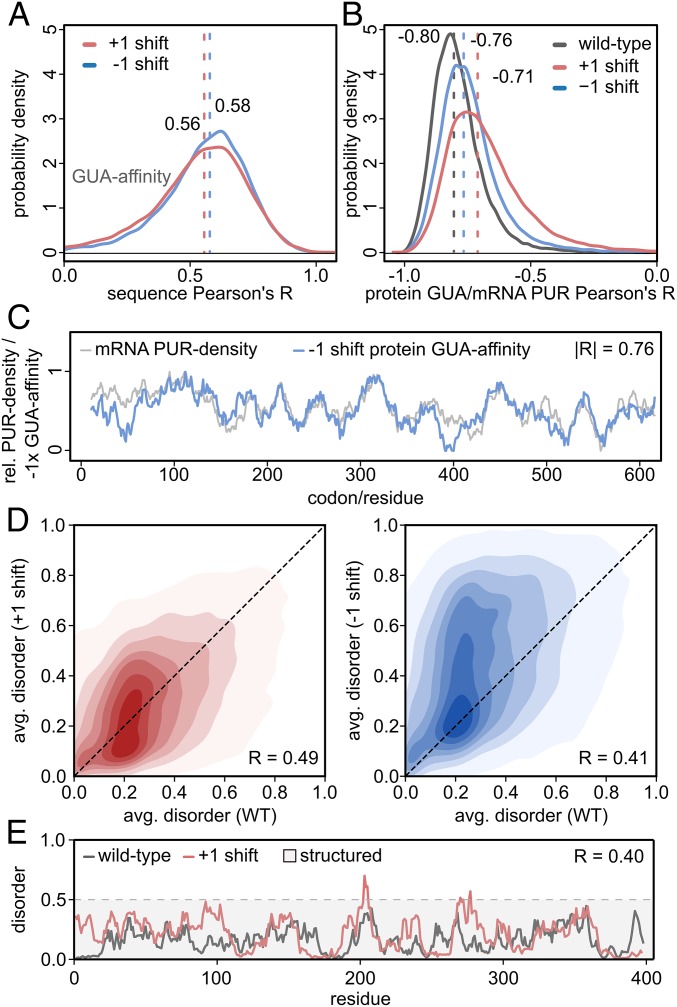
Frameshifting in the context of GUA affinity and intrinsic disorder. (A) Distributions of Pearson’s R between GUA-affinity profiles of wild-type and +1 or −1 frameshifted human protein sequences (n = 17,083). (B) RNA vs. protein: Distributions of Pearson’s R between mRNA PUR-density profiles and autologous protein’s GUA-affinity profiles in human for wild-type, +1 and −1 frameshifted sequences (n = 17,083) with medians indicated. Note that matched profiles are indicated by negative Pearson’s Rs due to the standard definition of GUA-affinity scales. (C) RNA vs. protein: Comparison of an mRNA PUR-density profile and protein GUA-affinity profile for the −1 frameshifted sequence of the nuclear RNA export factor (UniProtID: Q9GZY0). (D) Comparison of disorder values averaged over full sequences (avg. disorder) in wild-type (WT) and +1 (Left, red) or −1 (Right, blue) frameshifted sequences. (E) Example IUPRED (33) intrinsic disorder profiles of a wild-type protein and its +1 shift variant (UniProtID: P07093).